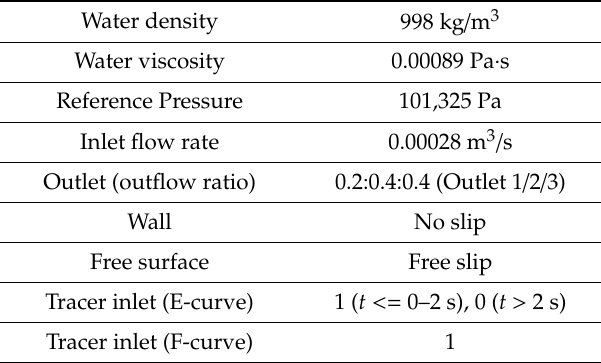
Table 2. Parameters and boundary conditions used in